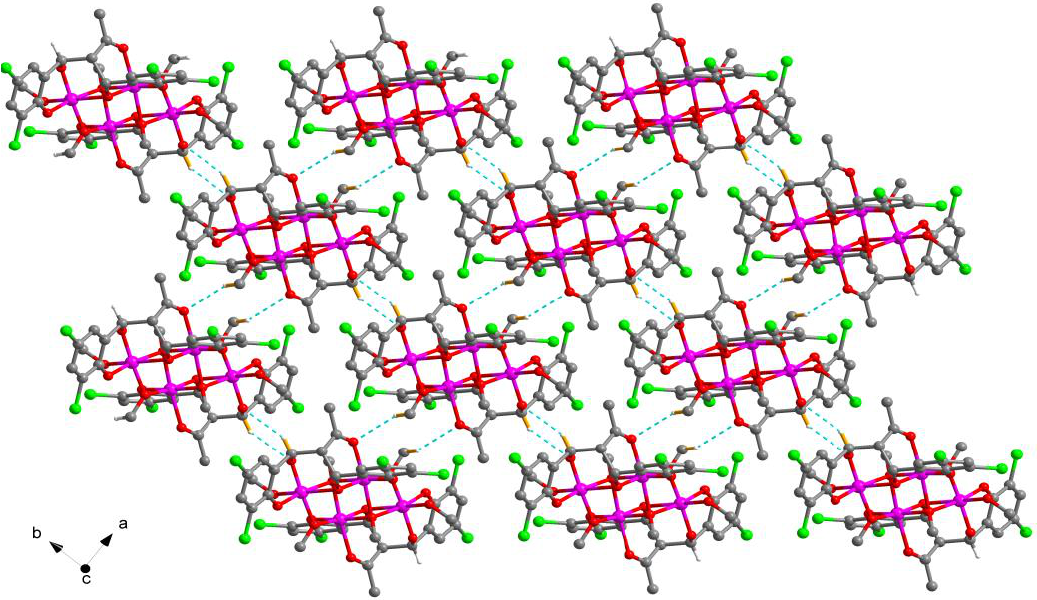
Figure 8. View of the 2D layered motif within Mn III complex 1 (hydrogen atoms, except those forming hydrogen bonds, are omitted for clarity).